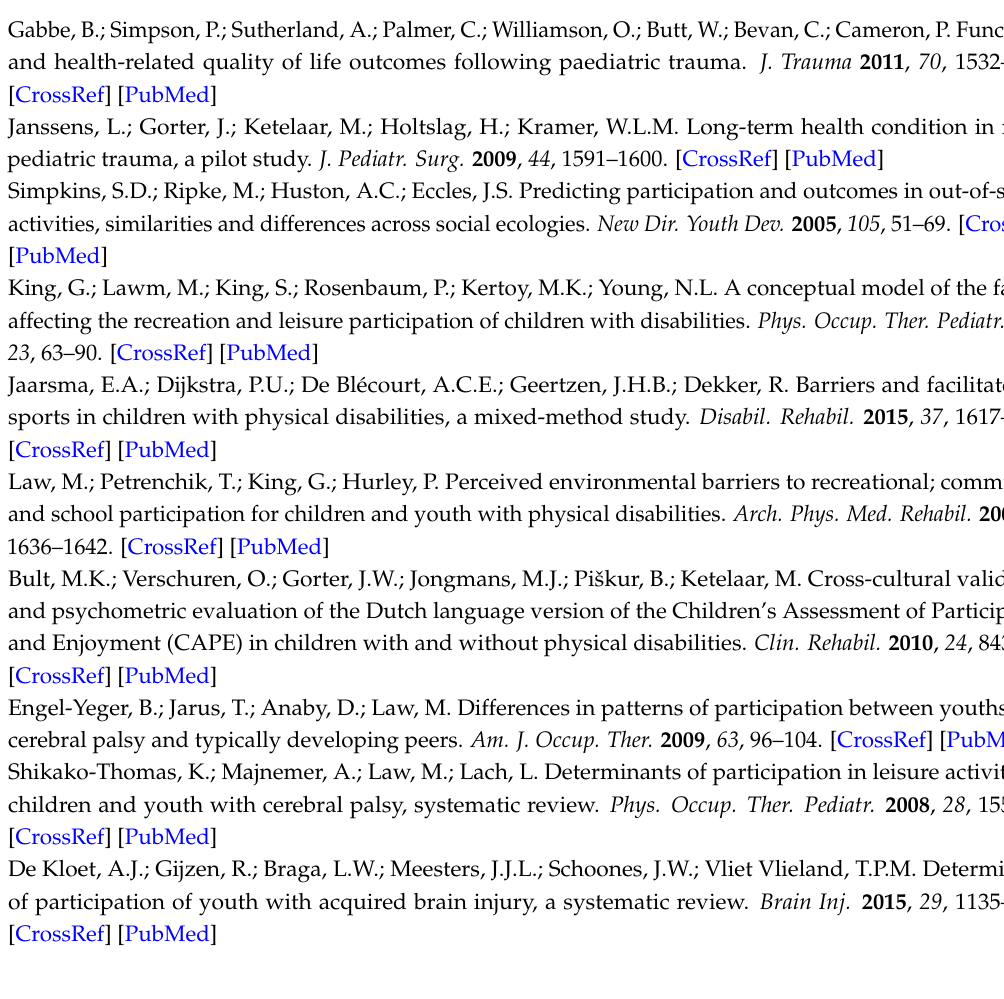
Table S1: Additional